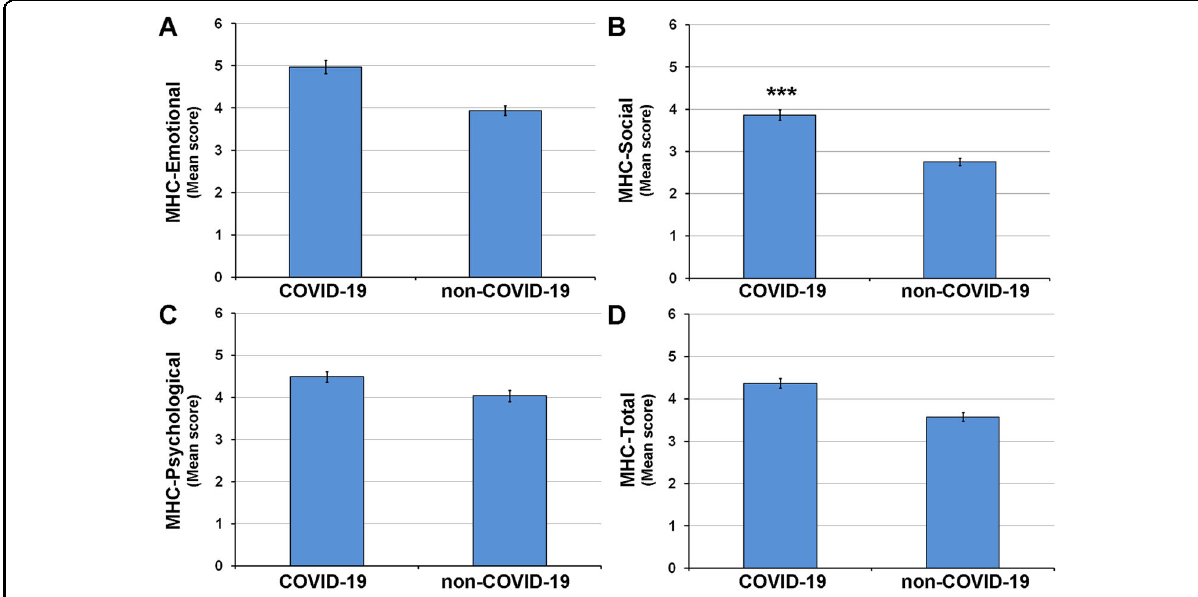
Fig. 3 COVID-19 physicians reported signi fi cantly higher score in the social MHC-SF well-being dimension. The Mental Health Continuum- Short Form (MHC-SF) in COVID-19 physicians compared with non-COVID-19 group: A emotional aspect, B social aspect, C psychological aspect, D MHC-SF total scores. *** P < 0.0001 (two-sided t